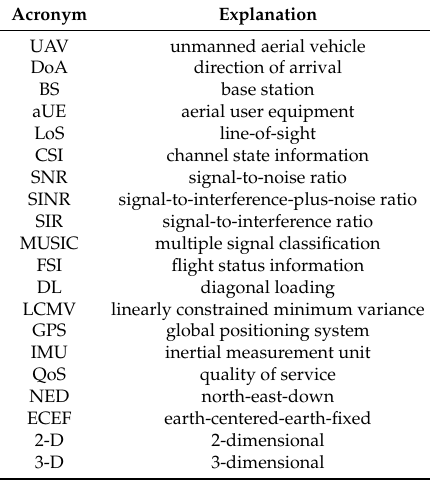
Table 1. Acronym